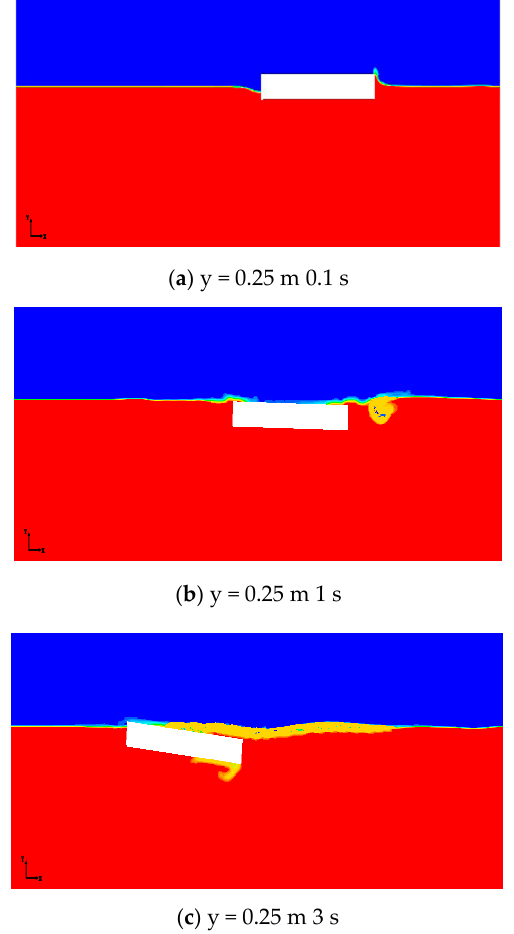
Figure 11. Oil spreading characteristics of the ice particle with 6DOF movement at y = 0.25 m plane section.